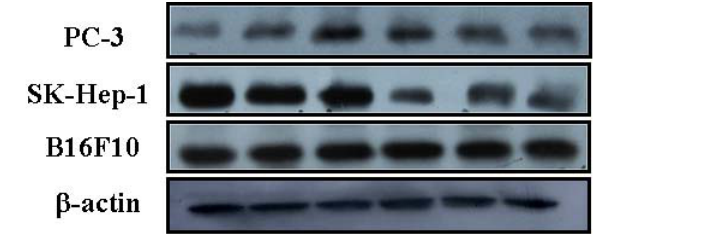
Figure 3. Effect of β -carotene (BC) on protein expression of VEGF in SK-Hep-1, PC-3 and B16F10 cells. Cells were incubated with BC (0–20 μ M) for 6 h. Data (means ± SD) are from three or four separate experiments; * P < 0.05; ** P < 0.01 compared to control (0 μ M β